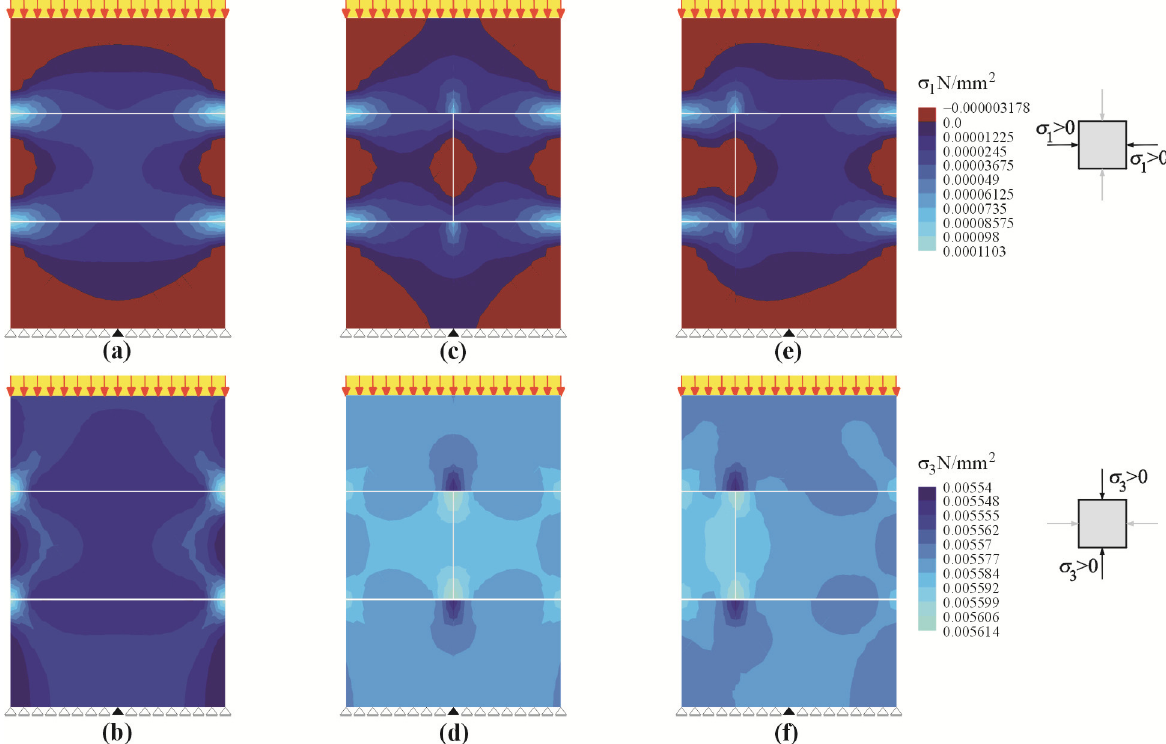
Figure 18. FEM calculations for the test walls: ( a ) stresses σ x in the model of series I without a head joint, ( b ) stresses σ y in the model of series I without a head joint, ( c ) stresses σ x in the model of series II with the head joint at mid-length of the element, ( d ) stresses σ y in the model of series II with the head joint at mid-length of the element, ( e ) stresses σ x in the model of series III with the head joint in 1/4 length of the masonry unit, ( f ) stresses σ y of the model of series III with the head joint in 1/4 length of the masonry unit.